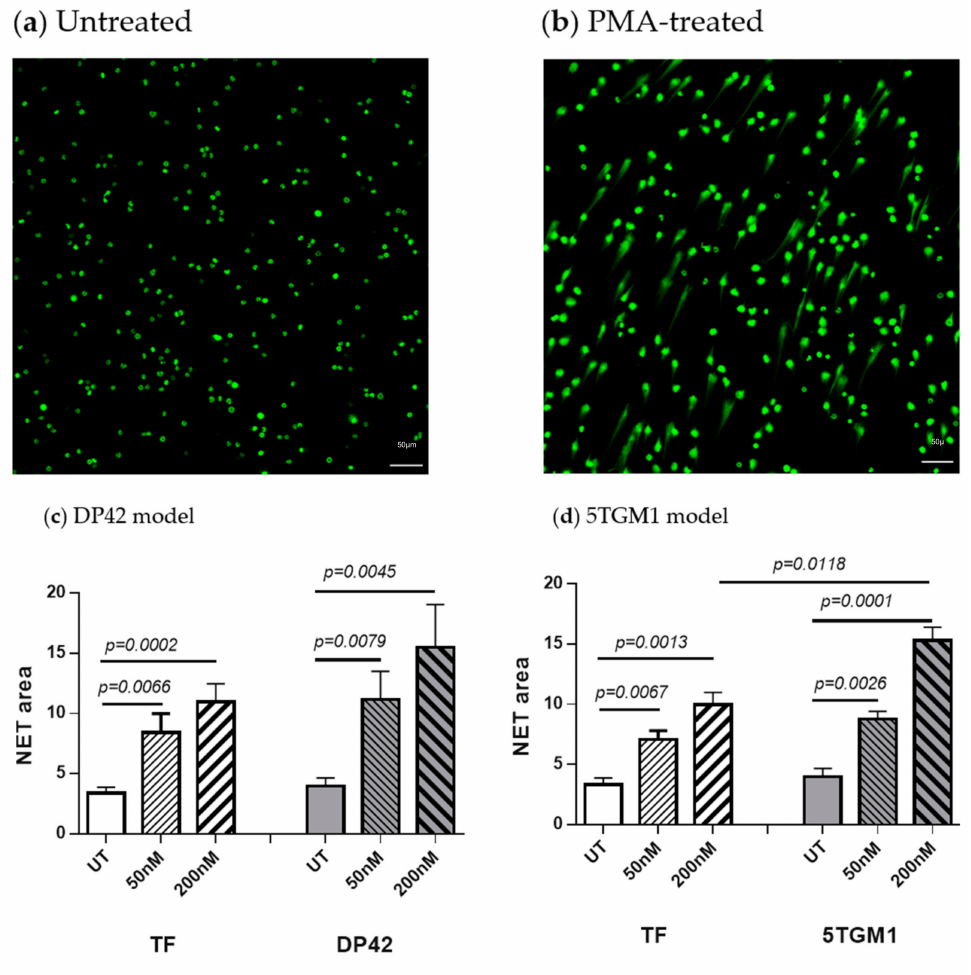
Figure 1. Neutrophil extracellular trap (NET) formation induced by phorbol 12-myristate 13-acetate (PMA). Neutrophils were isolated from the BM of DP42-bearing mice, 5TGM1-bearing mice, or control tumor-free (TF) mice and stimulated in vitro with 50 nM or 200 nM PMA for 4 h. Formation of NETs was evaluated by microscopy and quantified. ( a , b ) Representative images of untreated ( a ) or stimulated with PMA ( b ) neutrophils. ( c , d ) Quantitation of NET area for neutrophils from DP42-bearing ( n = 12) and tumor-free ( n = 9) mice ( c ) and 5TGM1-bearing ( n = 4) and tumor-free ( n = 4) mice ( d ). Mean ± SEM values are shown.